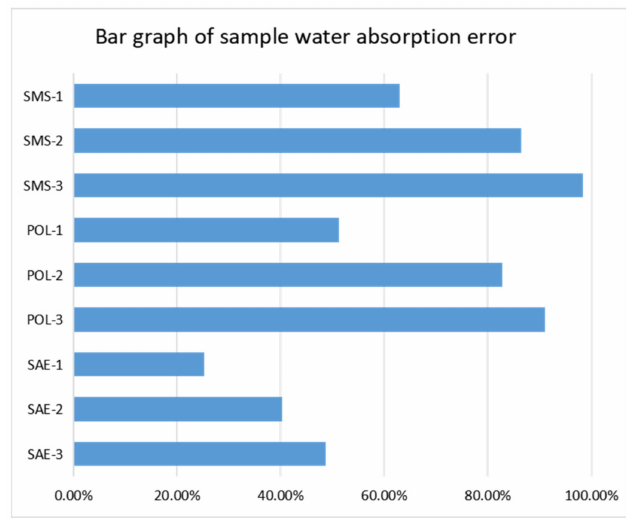
Figure 9. Bar graph of sample water absorption error.